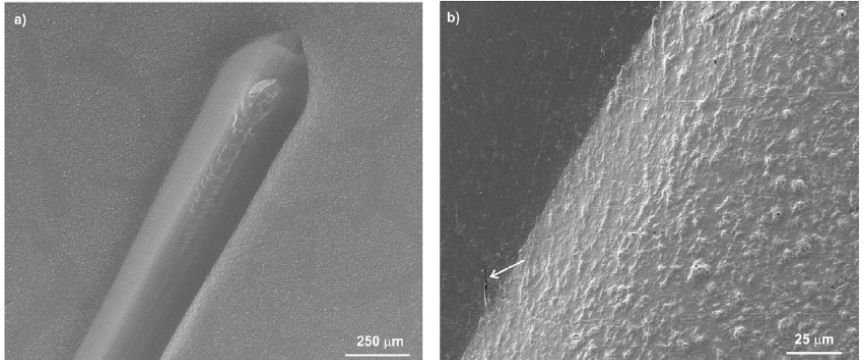
Figure 4. Scanning electron microscope (SEM) images of the poly(ether ether ketone) (PEEK) coating on Ti-13Nb-13Zr after scratch test at a load of 30 N ( a ) and 25 N ( b ). (Reprinted with permission from [63] 2016 Elsevier, copyright n. 4557620529187).